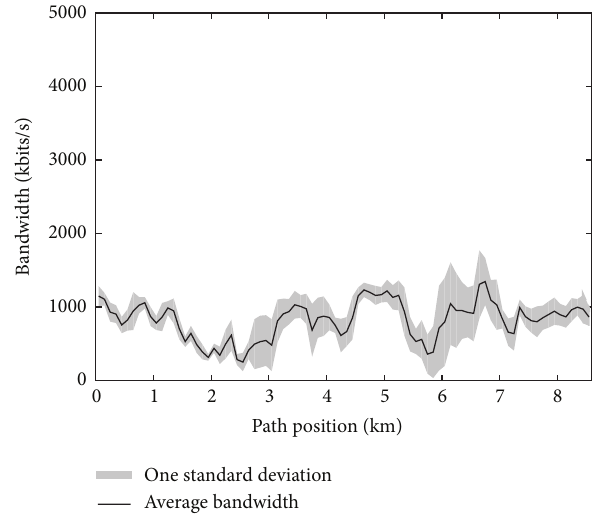
Figure 17: Average measured bandwidth along the tram commute path with standard deviation over multiple measurements.